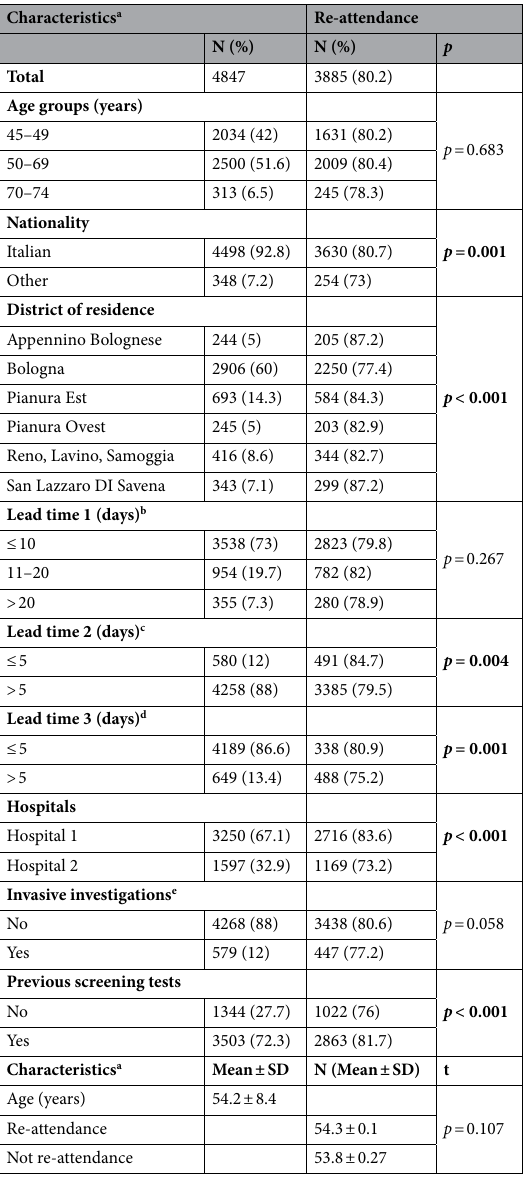
Table 1. Distribution of re-attendance according to several women and diagnostic work-up characteristics. Bold values indicates statistically significant difference a Total may not always sum to “n” because of missing data. b Lead time between I level mammography and I level diagnostic conclusion. c Lead time between